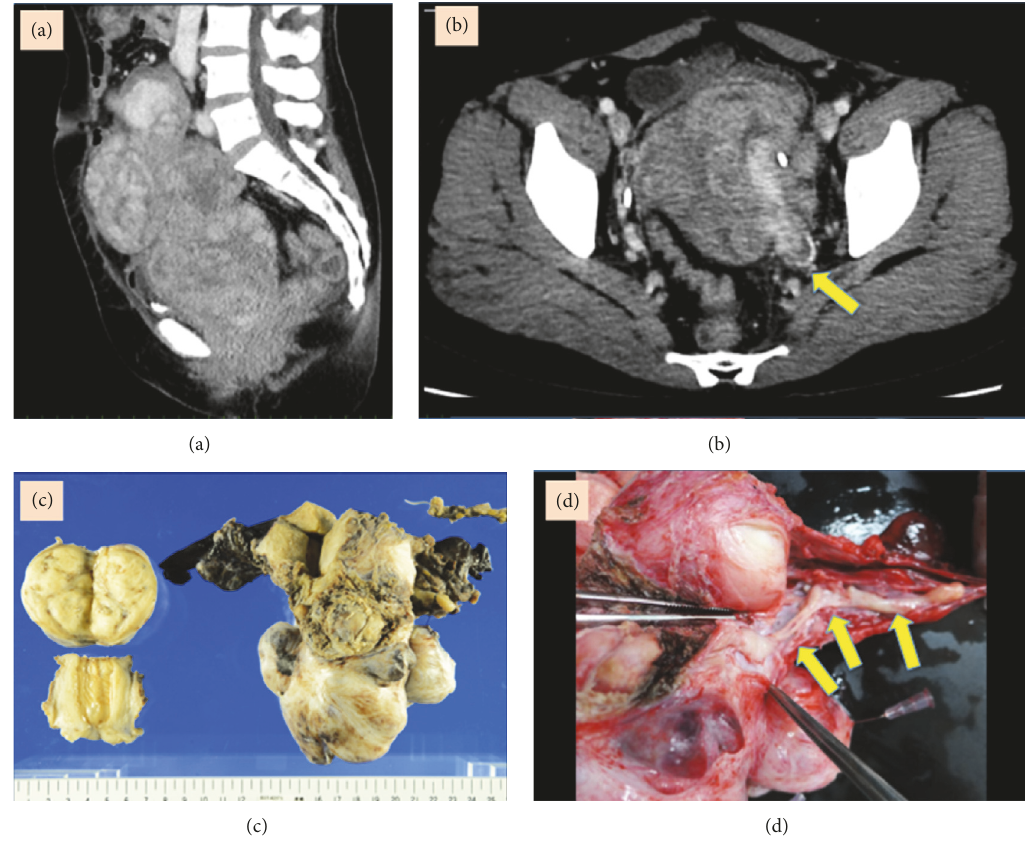
Figure 2: (a) Heterogeneous large tumor occupying the pelvic cavity on a computerized tomography scan. (b) Intravascular tumor within the dilated left internal iliac vein on a computerized tomography scan. (c) Multiple leiomyomas within the uterine corpus and cervix. (d) Tumor growth extending into the left ovarian